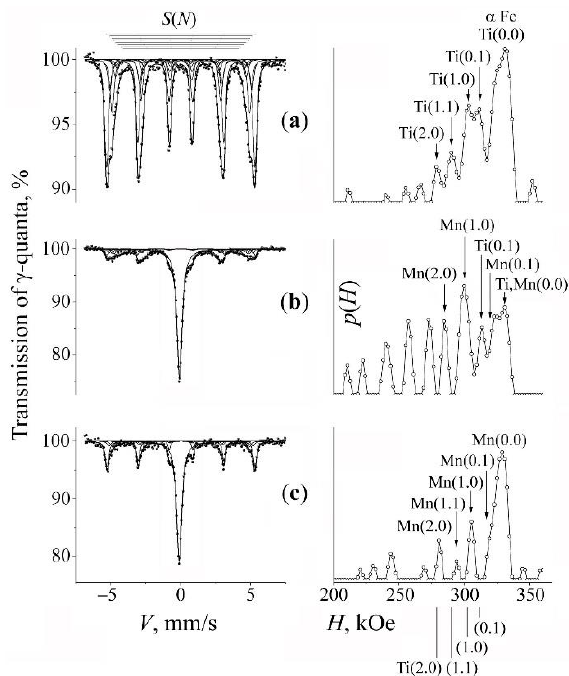
Figure 5. Mössbauer spectra of the mixture “D” (Fe–5Ti + MnN) and the distributions p ( H ) for the α -phase. Treatment: ( a ) — initial mixture; ( b ) — PBM, 10 h; ( c ) — PBM, 10 h + anneal 650 °C, 4 h. The arrows at the distribution p ( H ) mark the peaks corresponding to occupations by the impurity atoms Ti and Mn in the first two CSs of iron.